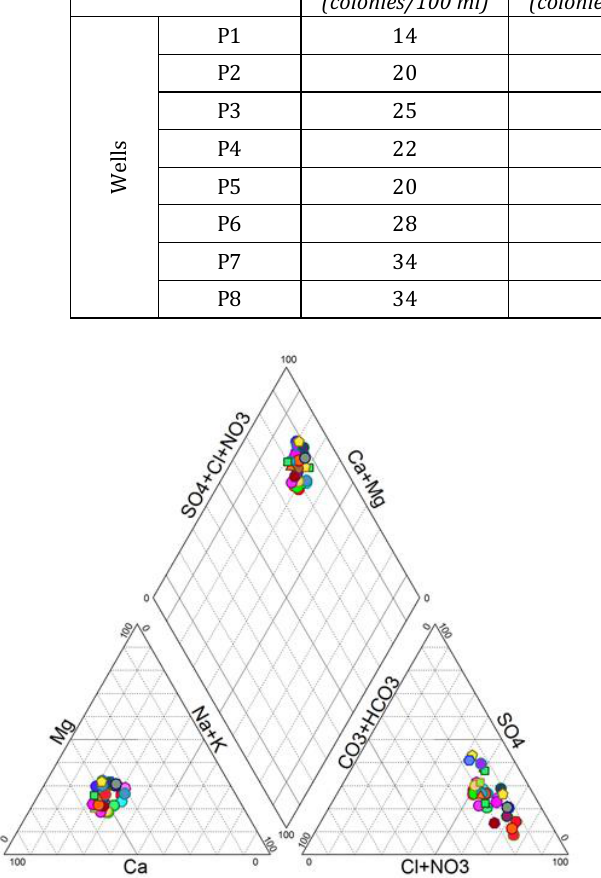
Fig. 6. Piper trilinear diagram plot of the groundwater samples (October